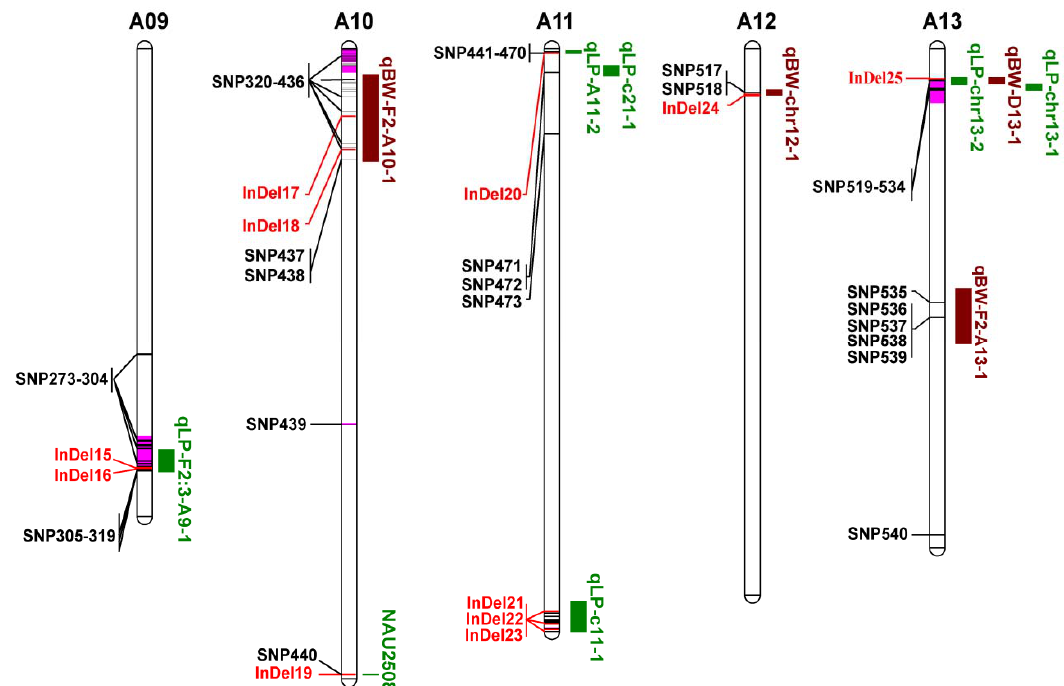
Figure 6. Physical map of SNPs and InDels which overlapped with the previous reported QTLs about LP and BW in A subgenome. The red line indicated the InDels, the QTL intervals of GWAS study were replaced by the pink color on the chromosomes and the green and brown bar indicated the LP QTLs and BW QTLs producing by QTL mapping study.